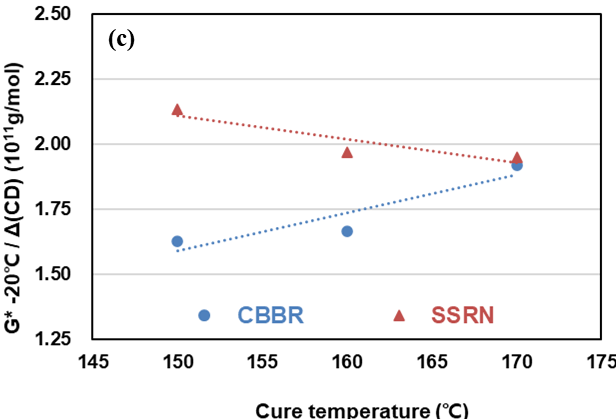
Figure 9. Change of viscoelasticity properties of the SBR binary filler compounds by different cure temperatures: ( a ) tan ẟ at 60 °C, ( b ) G ″ at 0 °C, and ( c ) G * at −20 °C. temperatures: ( a ) tan δ at 60 ◦ C, ( b ) G ” at 0 ◦ C, and ( c ) G * at − 20 ◦